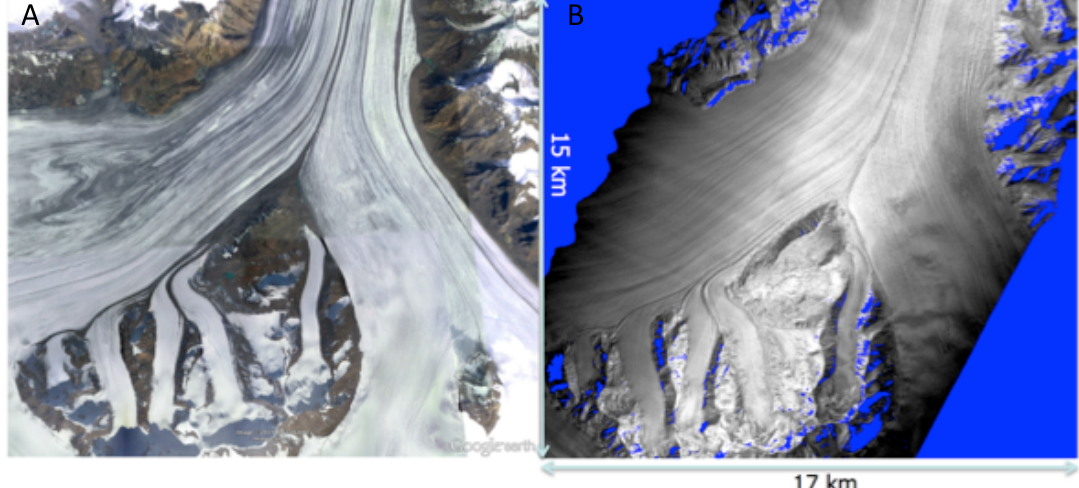
Figure 2. Imagery of Nabesna glacier: ( A ) Google Map image. ( B ) GLISTIN relative power